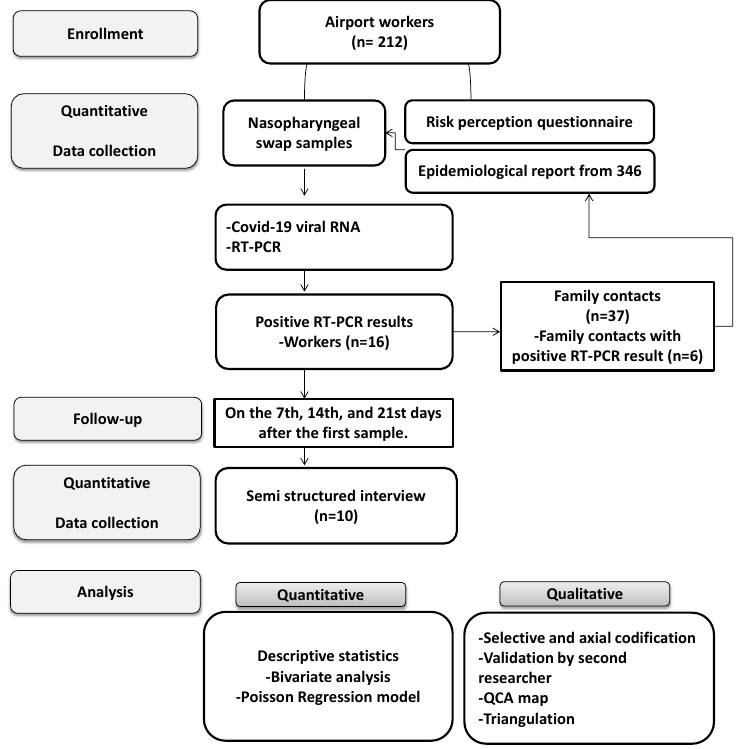
Figure 1. Description of the research process in the study.